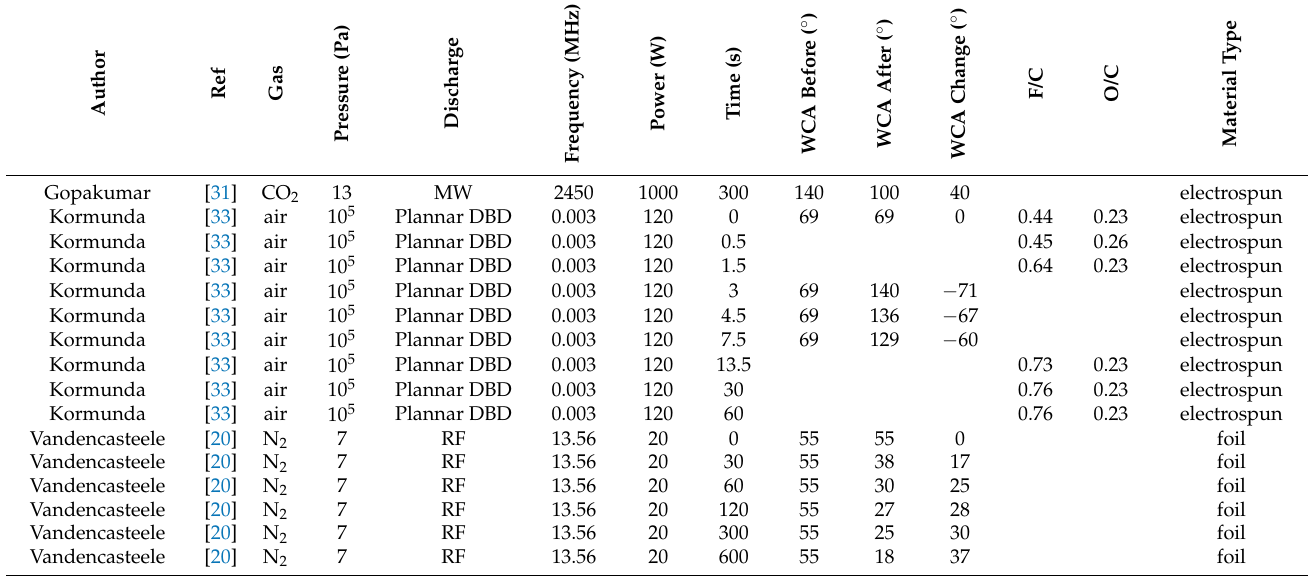
Table 3. Summary of results reported by various authors who have probed plasmas other than oxygen or argon.